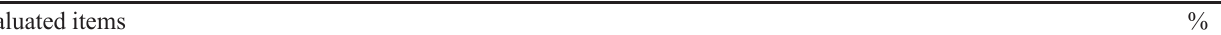
TABLE VI - Level of satisfaction of patients carrying human immunodeficiency virus (HIV) respecting the attendance provided by the pharmacist and respecting the Pharmaceutical Care program (n=15) (DHGMM, 2007) Evaluated